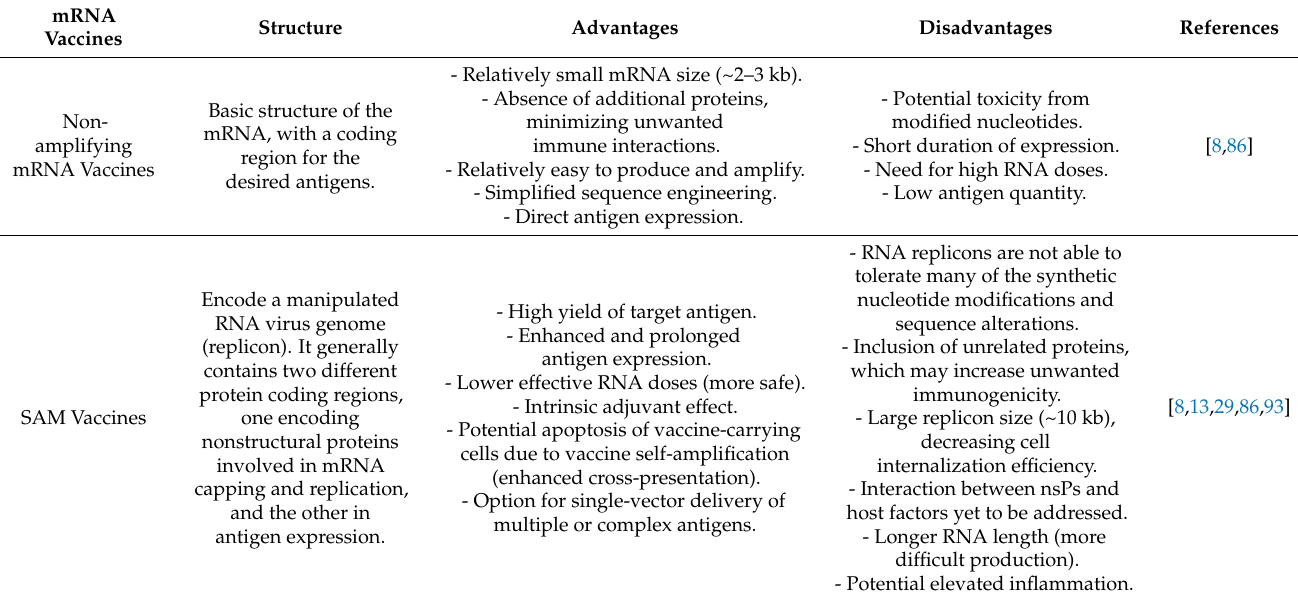
Table 3. Advantages and disadvantages of non-amplifying mRNA Vaccines and SAM Vaccines. mRNA Structure Advantages Disadvantages Vaccines